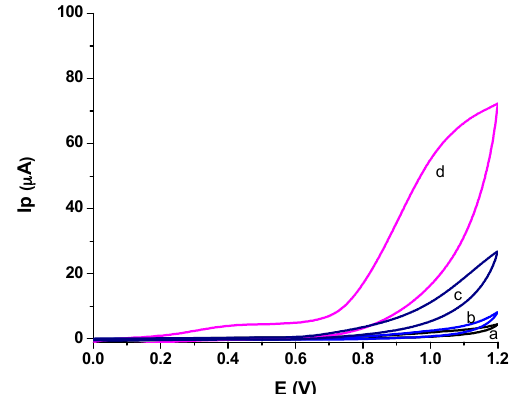
Figure 4. Cyclic voltammograms obtained for 1 mM nitrite solution in phosphate buffer (pH 7.0) and scan rate of 100 mV s − 1 using ( d ) Px-CuO NSs-modified GCE and ( c ) bare GCE. Curves ( a ) and ( b ) are the CV responses of the blank solution (phosphate buffer, pH 7.0) using bare and Px-CuO NS-modified GCE, respectively.